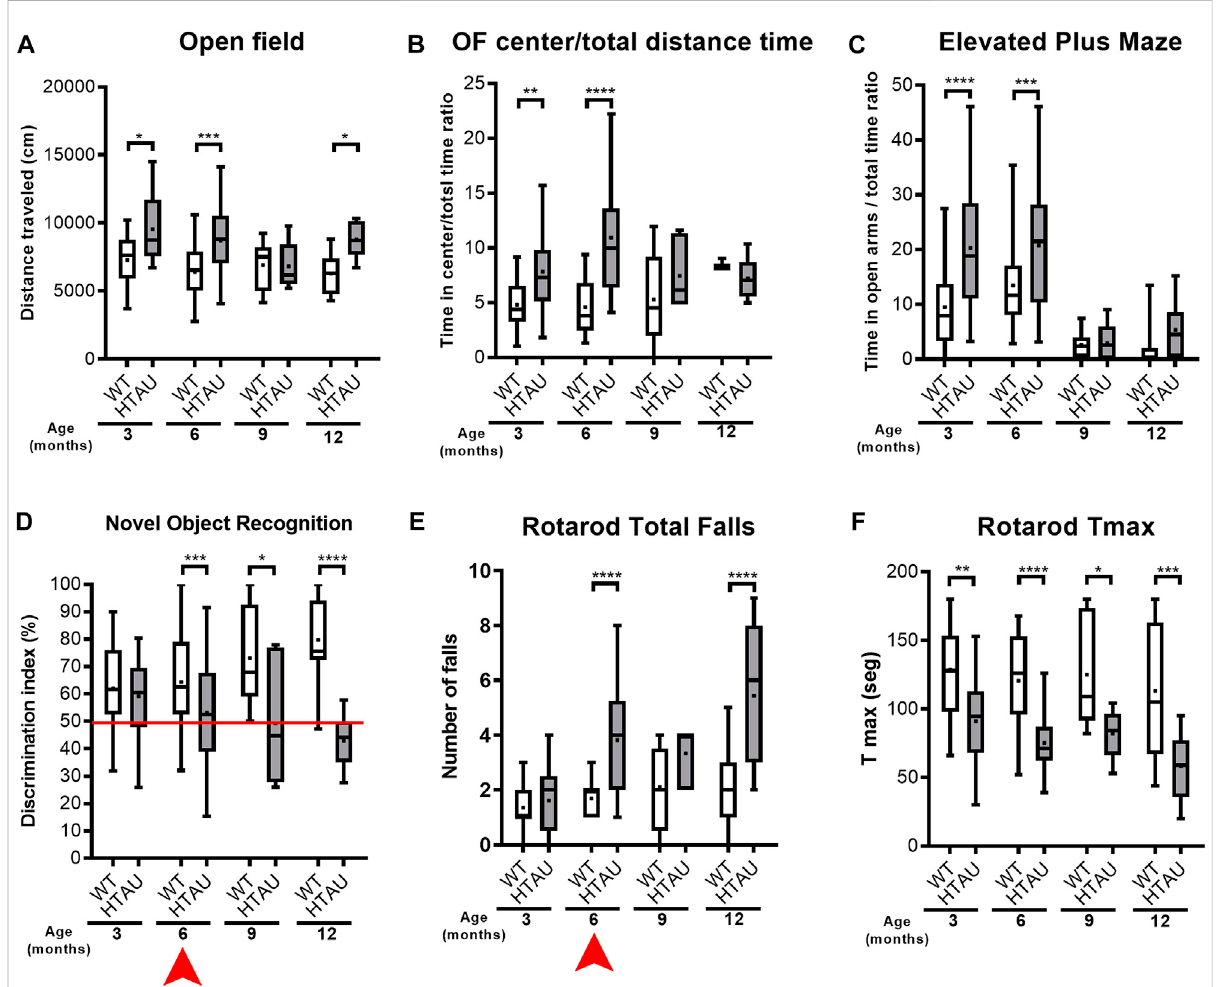
FIGURE 1 Timecourseofcognitiveandmotorde fi citsinhtaumice.HtauandWTmiceweretestedinabatteryofbehaviouraltestsat3,6,9and12